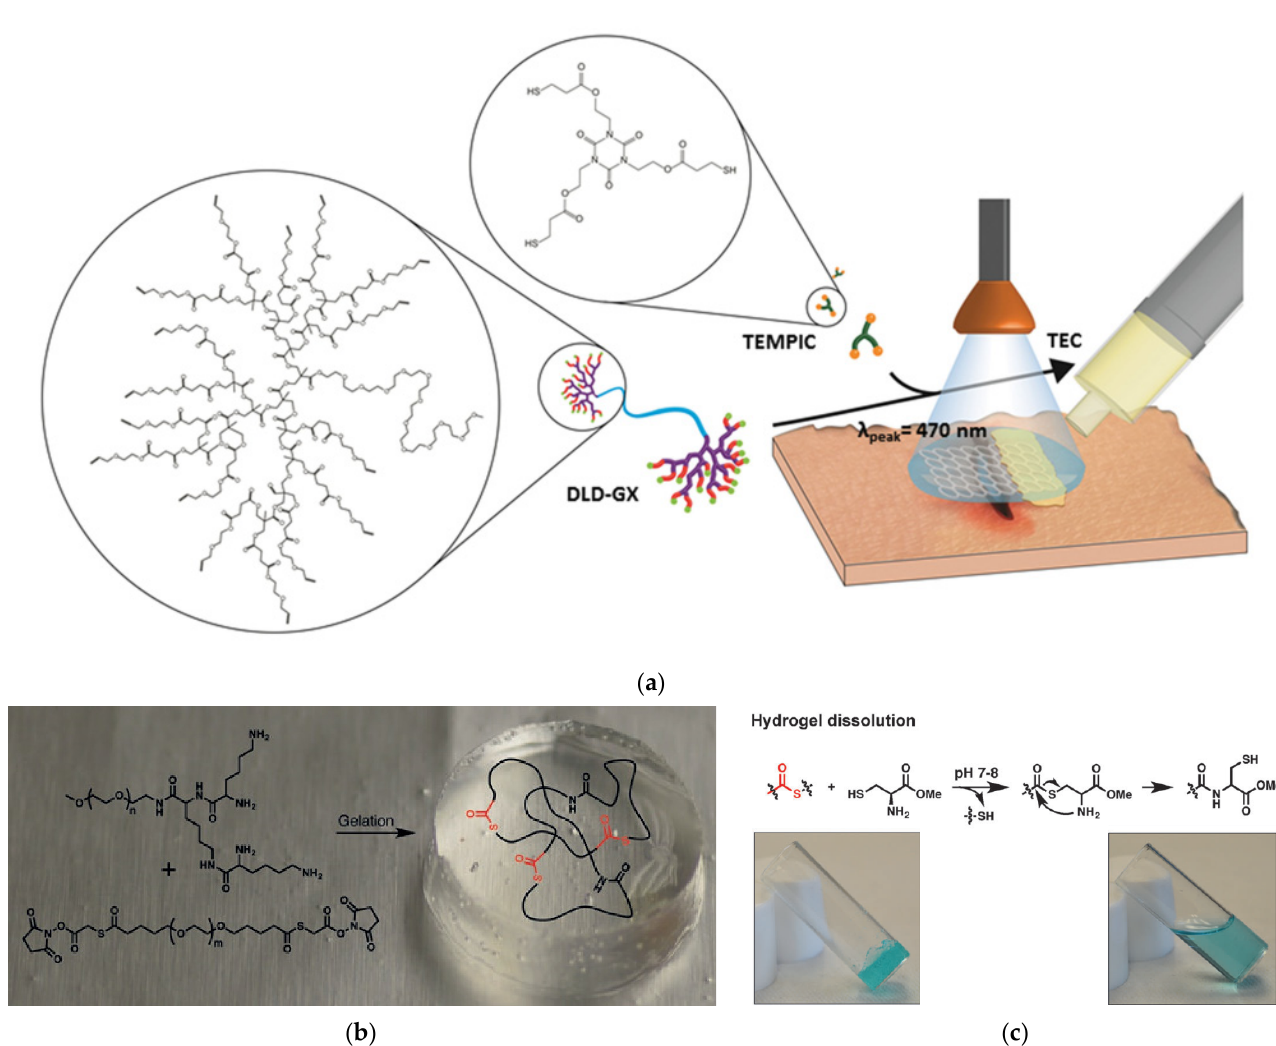
Figure 29. Schematic illustration of the fabrication of solvent-free adhesive using the dynamic thiol– aldehyde crosslinking chemistry and its administration using a hot-melt adhesive applicator. Re- produced with permission from [272]. Copyright: Royal Society of Chemistry.